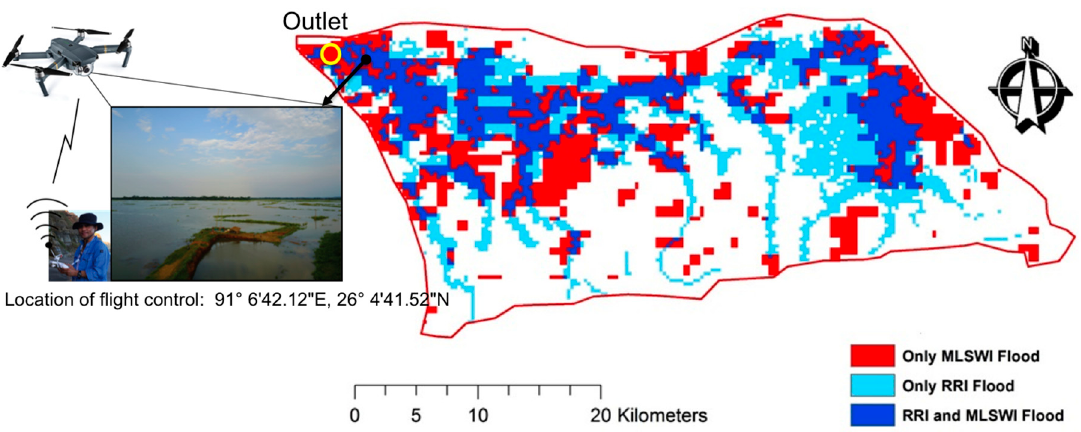
Figure 10. Resultant inundation areas. ( a ) Comparison of the best performing Rainfall-Runoff-Inundation (RRI) model (ASTER DEM with the denoising algorithm) with the MODIS-detected extent by the Modified Land Surface Water Index (MLSWI). ( b ) Field investigation using a small unmanned aerial vehicle (sUAV).